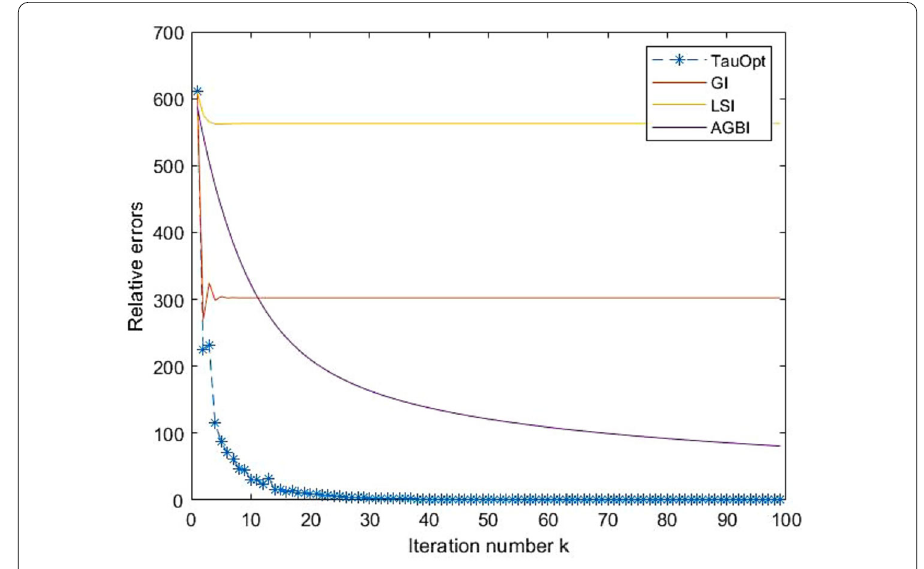
Figure 3 Relative errors for Ex. 5.3